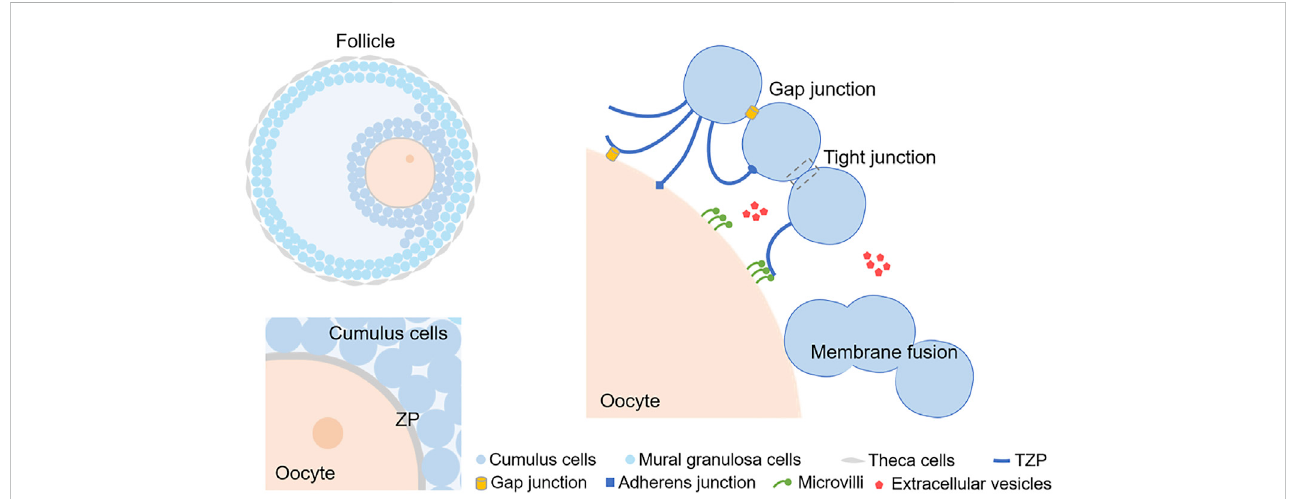
FIGURE 1 A schematic diagram exhibiting the intercellular communication in cumulus-oocyte complex. The simple diagram of cumulus oophorus in an antral follicle is showed at top left. The 2 layers of cells adjacent to the oocyte are CCs and the cells in the outer layers of the follicle are mural granulosa cells. ZP surroundstheplasmamembraneoftheoocyte,whichislabeledatlowerleft.TZPscanprotrudethroughtheZPtotheoocyteandformconnections.Microvilli appear on the surface of the oocyte, and they can either contact with TZPs or release EVs. EVs can also be released by CCs. Cell membrane fusion is another phenomenon occurring both in oocytes and CCs. CC, Cumulus cell; ZP, Zona pellucida; TZP, Transzonal projection; EV, extracellular